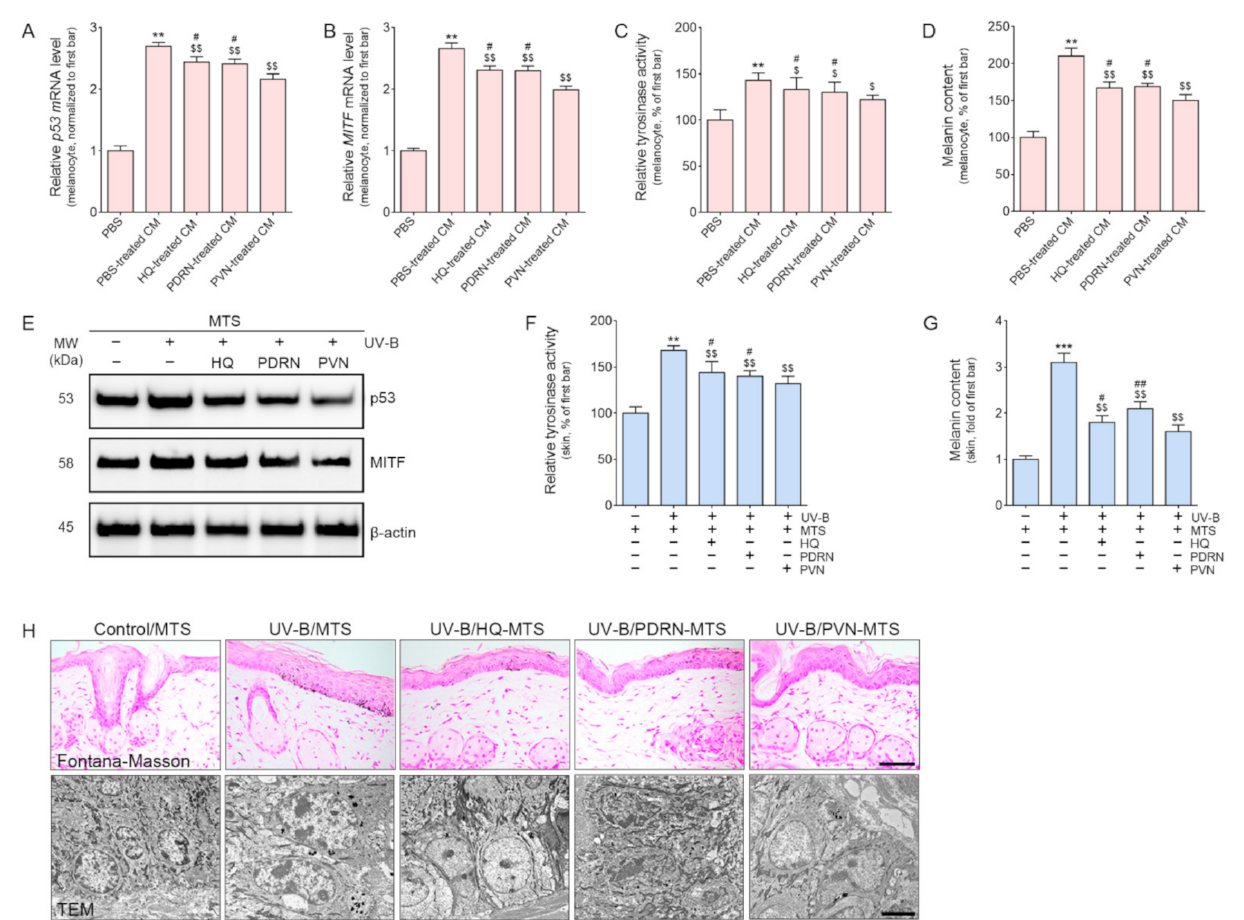
Figure 2. Regulation of the expression of p53 and MITF and tyrosinase activity by HQ, PDRN, and PVN treatment. ( A , B ) The mRNA expression levels of p53 ( A ) and MITF ( B ) were determined in the melanocytes treated with PBS or CM from UV-B-radiated keratinocytes. CM was obtained from a UV- B-radiated keratinocyte culture treated with HQ, PDRN, or PVN. The mRNA levels were normalized by Actb and expressed relative to the levels in the PBS group. ( C , D ) The tyrosinase activity ( C ) and melanin contents ( D ) determined in the melanocytes treated with PBS or CM from UV-B-radiated keratinocytes. ( E ) Immunoblot analysis of p53 and MITF determined in the UV-B-radiated animal skin. ( F ) The tyrosinase activity was evaluated in the UV-B-radiated animal skin. ( G ) The melanin contents evaluated with Fontana–Masson staining in the UV-B-radiated animal skin was exhibited as a graph. ( H ) The melanin content was assessed by Fontana–Masson staining (upper row; scale bar = 100 µ m) and TEM (lower row; scale bar = 5000 nm). Melanin is stained as blackish dots in the Fontana–Masson staining. Data are presented as the mean ± standard deviation: **, p < 0.01 and ***, p < 0.001 vs. first bar; $, p < 0.05 and $$, p < 0.01 vs. second bar; #, p < 0.05 and ##, p < 0.01 vs . 5th bar (Mann–Whitney U test). CM, conditioned medium; HQ, hydroquinone; MITF, microphthalmia-associated transcription factor; MTS, microneedling therapy system; MW, molecular weight; PBS, phosphate-buffered saline; PDRN, polydeoxyribonucleotide; PVN, polydeoxyribonucleotide + vitamin C + niacinamide; p53, tumor protein p53; TEM, transmission electron microscopy; UV-B, ultraviolet